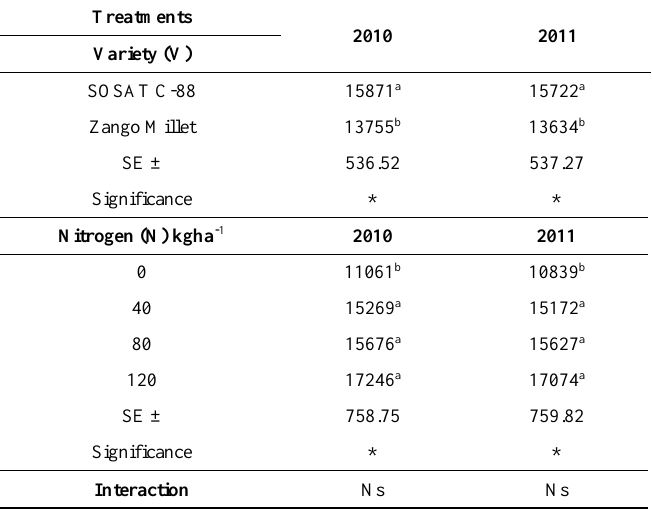
Table 7. Effect of varieties, nitrogen levels on Stover yield (kgha-1) in 2010 and 2011 cropping seasons at Usmanu